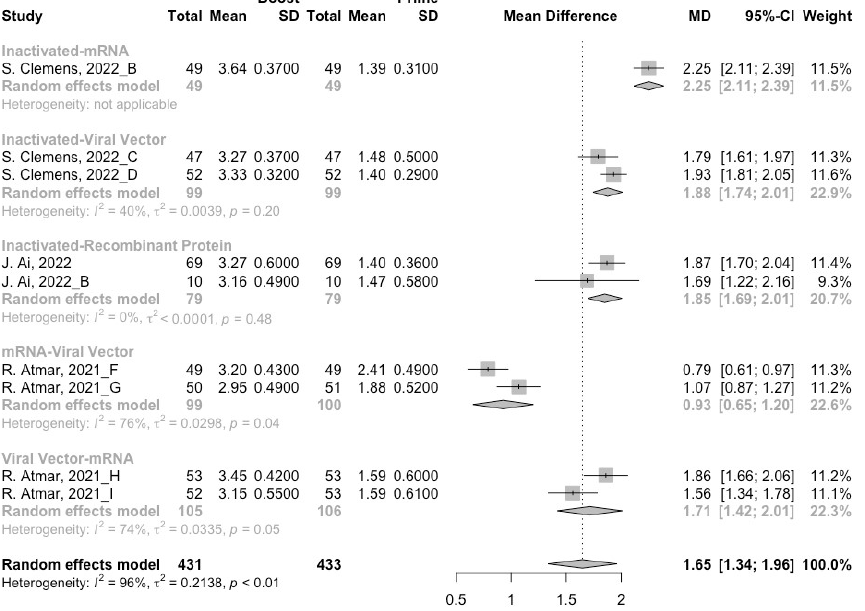
Figure 9. Forest plot of the pooled log-transformed neutralization titers against the wild type before and after heterologous booster vaccination [2,18–32].